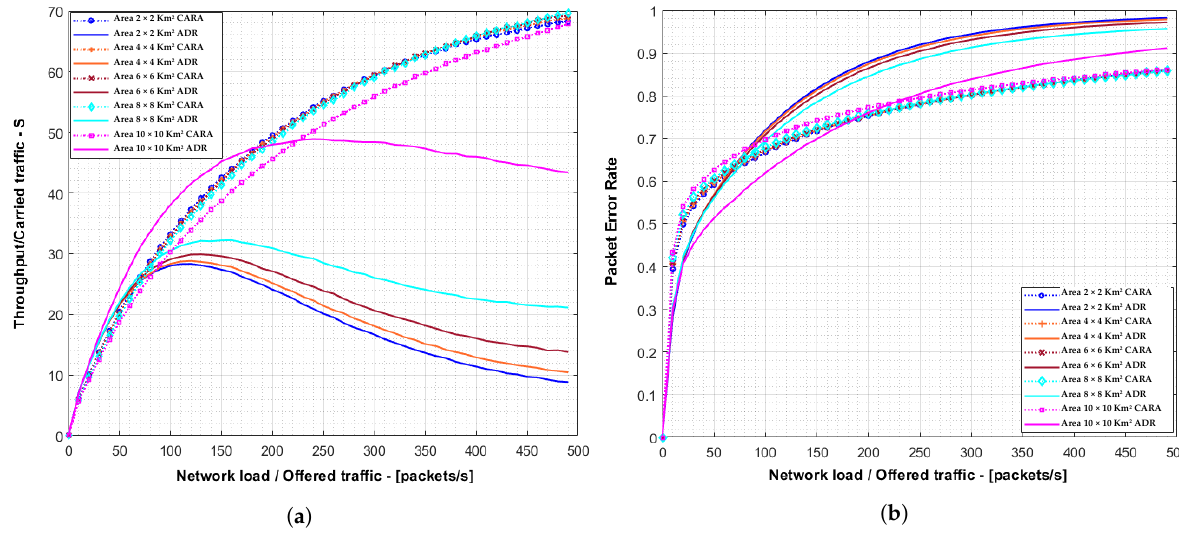
Figure 11. Throughput and PER for 1000 devices in the case of non groups of SF with different area dimensions. ( a ) Mean throughput of the system for ADR and CARA cases. ( b ) Packet Error Rate of the system in ADR and CARA